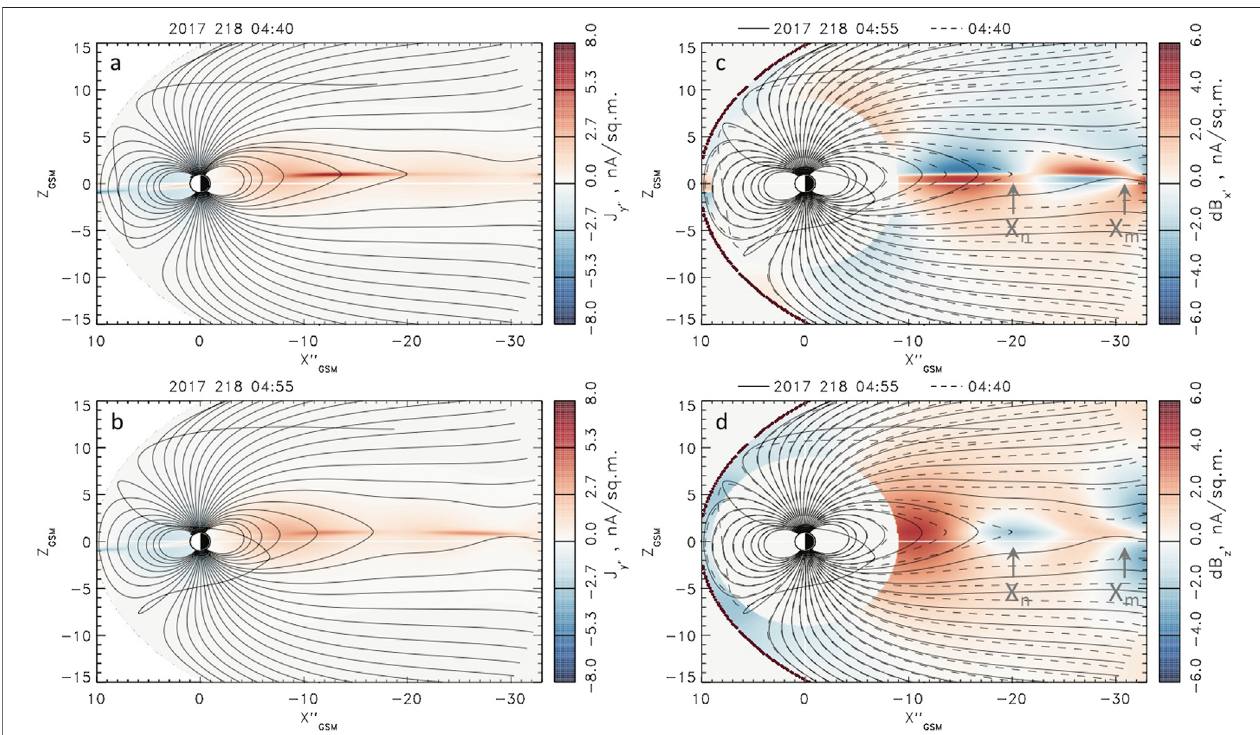
FIGURE 11 | (A, B) Color-coded distributions of the current density component J y ″ normal to the meridional plane shown by the dashed lines in Figure 7 with overplotted magnetic fi eld lines (black solid lines) for the moments t 0 (cid:1) 04 : 40 UT and t 2 (cid:1) 04 : 55 UT of the second dipolarization during the 6 August 2017 substorm. (C, D) Color-coded distributions of the x ” - and z-components of the magnetic fi eld variation between moments t 0 (cid:1) 04 : 40 UT and t 2 (cid:1) 04 : 55 UT dB x ″ , z (cid:1) B x ″ , z ( t 2 ) − B x ″ , z ( t 0 ) inthesamemeridionalplanewithoverplottedmagnetic fi eldlines(solidlinesforthemoment t 2 anddashedlinesforthemoment t 0 ). x ″ GSM isthecoordinate along the dashed lines in Figure 7 .